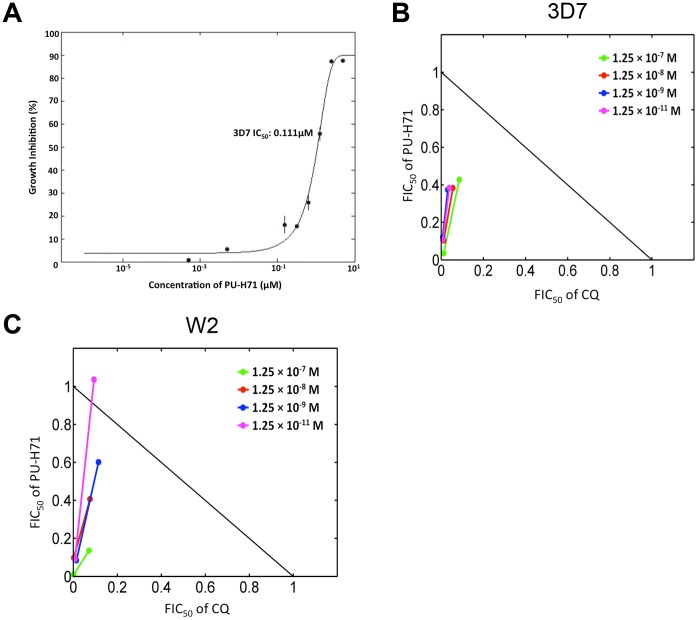
Assessment of the in vitro antimalarial activity of PU-H71.(A) Antimalarial activity of PU-H71 using a standard SYBR Green cell-based assay using the laboratory strain 3D7 resulted in an IC50 of 89.4±15.3 (SEM) nM (n = 3, performed in duplicate). A single representative experiment performed in duplicate is depicted here resulting in a IC50 of 111±8 nM (SD). Antimalarial activity of PU-H71 using the strain W2 resulted in an IC50 of 94.3±6.3 (SEM) nM. (B) PU-H71 acts synergistically with chloroquine (CQ) in a CQ sensitive strain (3D7). Synergistic activity was defined by calculations of the average sum fractional inhibitory concentration ratio (FIC) FIC50 and by the FIC50 ratios lying under the line corresponding to additive activity. (C) PU-H71 acts synergistically with chloroquine (CQ) and potentiates CQ activity in the CQ resistant strain W2. The dots on the isobolograms represent the average of technical duplicates. The calculations for the FIC ratios are enclosed in Table S2. The response modification index (RMI) was calculated for each of the doses tested in both 3D7 and W2 strains and has been summarized in Table 1.